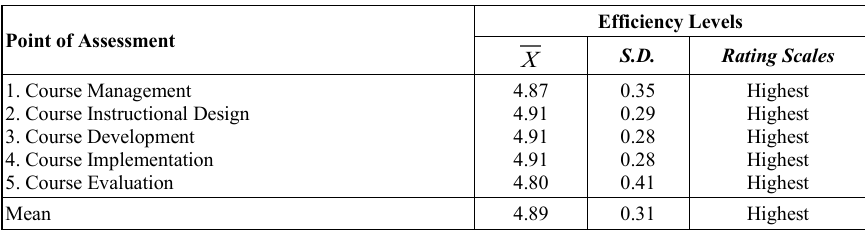
Table 4. Efficiency of the MOOCs knowledge repository system using a digital